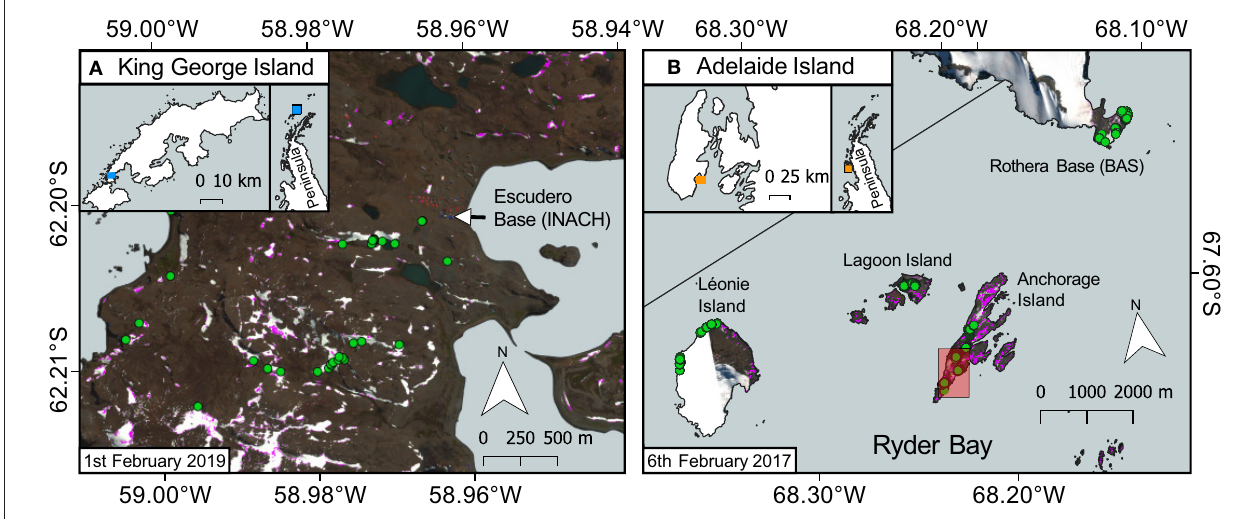
FIGURE 1 | Ground validation sites. WorldView 3 red–green–blue (RGB) images of our ground validation sites, the extent and location of which are denoted by the blue- or orange-shaded areas in their respective inset maps. Green circles show locations where snow algae were visibly growing on the snow surface, were geotagged, measured with the field spectrometer, and sampled for microscopy analysis. Pink pixel shading denotes areas of snow identified as containing snow algae within those WorldView 3 images, using the approach outlined below. (A) Sampling conducted in the Fildes Peninsula region of King George Island whilst stationed at Professor Julio Escudero Station and Refugio Collins in 2019. (B) Sampling conducted in the Ryder Bay area of Adelaide Island, showing Rothera Research Station and the outlying islands from which snow algae were sampled in 2018. Red shaded box on Anchorage Island denotes the area shown in Figures 9 , 12 . Map data from the SCAR Antarctic Digital Database.